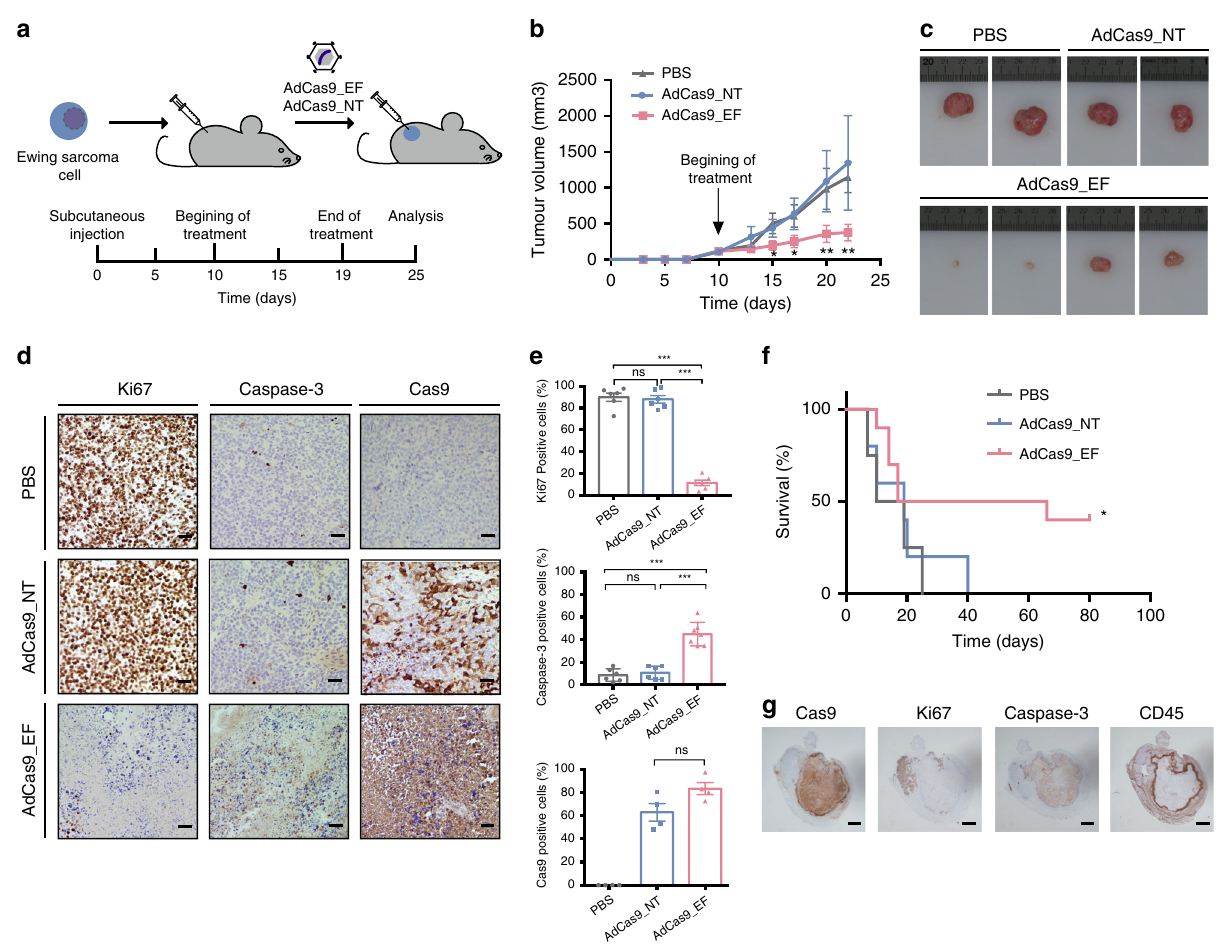
Fig. 3 Deletion of EWSR1-FLI1 inhibits tumor growth in xenografted models. a Diagram showing the approach for the in vivo xenograft treatment. A673 cells were subcutaneously injected into immunode fi cient mice and tumors were allowed to develop (~150 mm 3 in size). Tumors were then injected with AdCas9_EF edition vector, AdCas9_NT control vector or PBS at days 10, 13, 16, and 19. Mice were sacri fi ced when tumor volume reached 1500 mm 3 . b Tumor growth over 23 days of analysis. (PBS n = 6; AdCas9_NT n = 6; AdCas9_EF n = 15 animals), ** p = 0.004. c Images of representative tumors. d Representative immunostaining for Ki-67, caspase-3 and Cas9 in A673 experimental and control tumors ( n = 3 independent samples). Scale bars, 50 μ m. e Statistical analysis of the percentage of Ki-67- (PBS vs AdCas9_EF *** p = 1e-8, AdCas9_NT vs AdCas9_EF *** p = 6e-9), caspase-3- (PBS vs AdCas9_EF *** p = 1e-5, AdCas9_NT vs AdCas9_EF *** p = 5e-5) and Cas9-positive cells. f Kaplan – Meier survival curve comparing mice treated with experimental and control AdV or PBS. (PBS n = 4; AdCas9_NT n = 5; AdCas9_EF n = 10 animals), * p = 0.046. g Representative immunostaining for Cas9, Ki-67, caspase-3, and CD45 in an AdCas9_EF-treated xenografted tumor. The error bars indicate the s.e.m. for the averages across the multiple experiments; p -values are represented (ns non-signi fi cant; * p ≤ 0.05; ** p ≤ 0.01; *** p ≤ 0.001). A two-tailed unpaired t -test was used for statistical analysis of b , d , and log-rank test for f